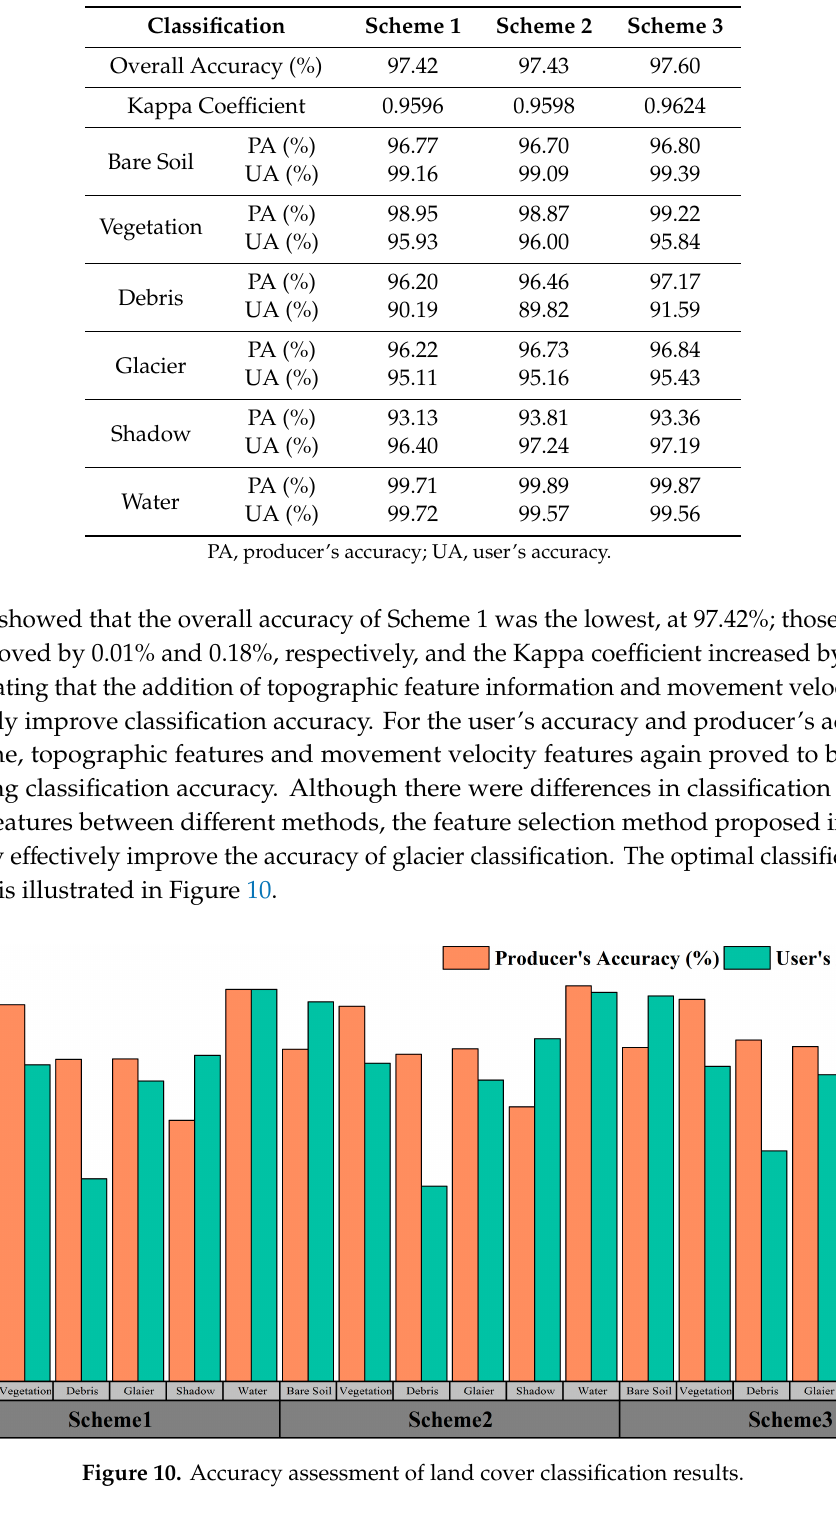
Table 5. Accuracy Statistics of Classification Results.